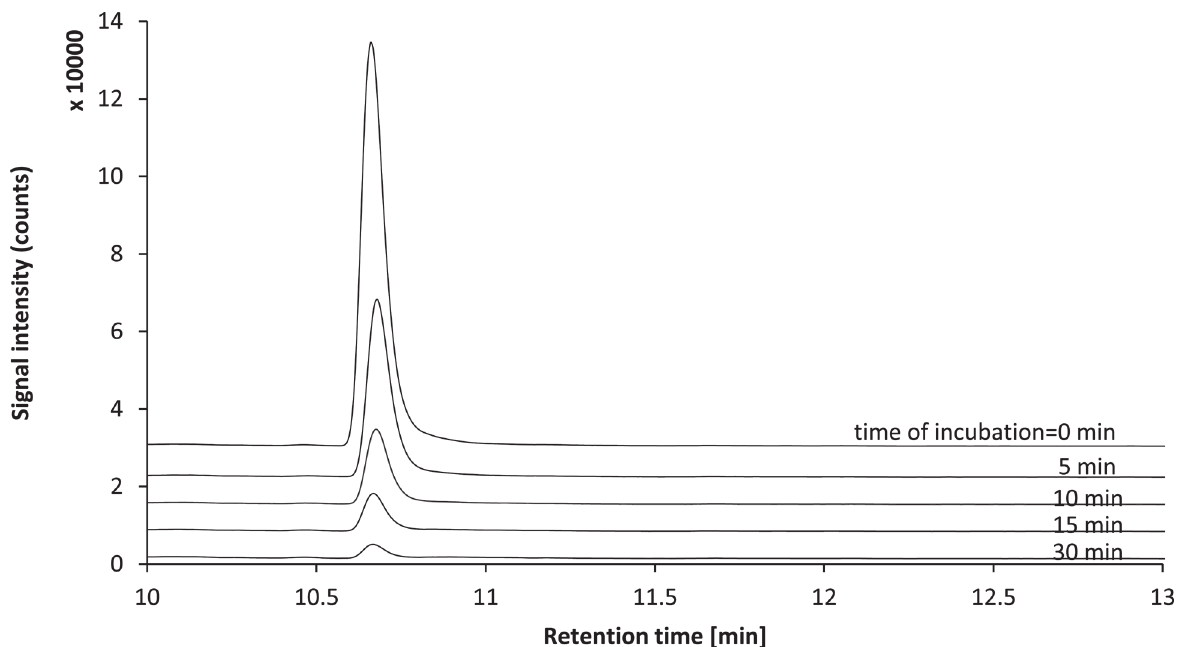
Fig 2. Time course of biotransformation of compound 3 in the presence of HLM and NADPH. Example single ion monitoring chromatograms (SIM, m/ z = 503.22) obtained for samples taken immediately after addition of HLM and after 5, 10, 15 and 30 minutes are shown.